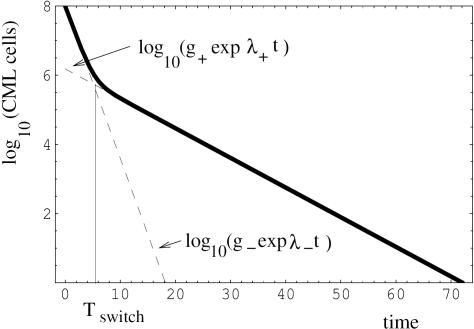
Biphasic decline of the CML cell population as a function of time, for parameters l = 1, d = 1.5, α = 0.01, β = 0.2, I0 = 108 and J0 = 102.The solid line represents log10(x(t)+y(t)), and the dashed lines are log10(g+exp{λ+t}) and log10(g-exp{λ-t}) (See Text S1, Section 1.1 and 1.2 for details). The time of treatment in this case is Ttreat = 72.1 and the switching time is Tswitch = 5.1.